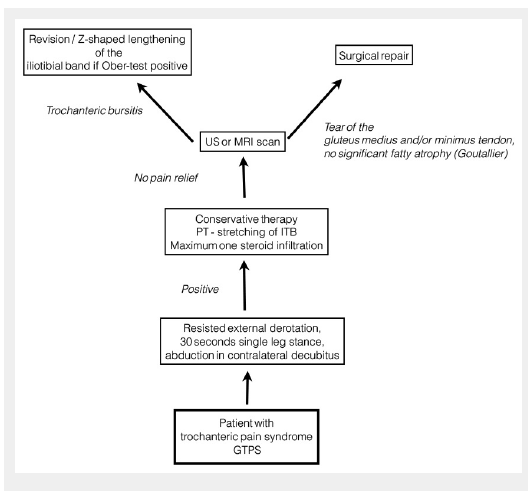
Diagnostic algorithm for greater trochanteric pain after total hip replacement [58, 95]. ITB = iliotibial band; MRI = magnetic resonance imaging; PT =